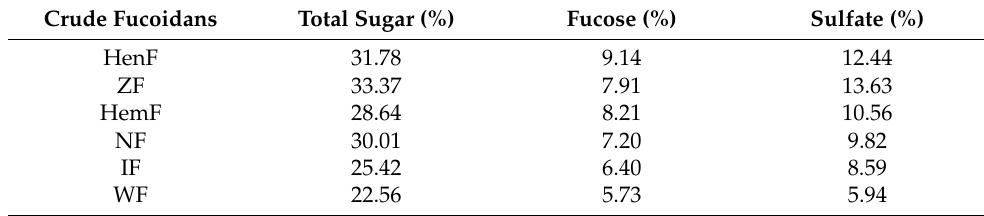
Table 1. The chemical composition of six crude fucoidans. Sargassum crude fucoidans includes HenF, ZF, HemF, NF, IF, and WF, respectively, from Sargassum henslowianum , Sargassum zhangii , Sargassum hemiphyllum , Sargassum naozhouense , Sargassum integerrimum, and Sargassum wightii . Chemical composition includes total sugar, fucose, and sulfate.